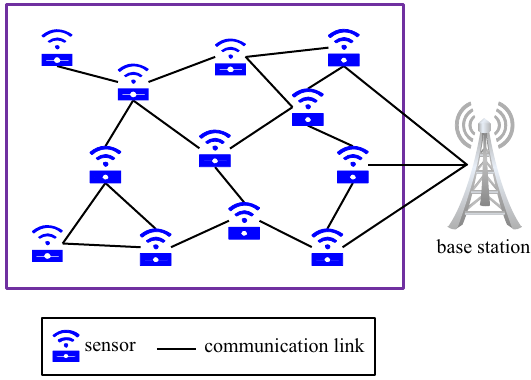
Figure 1. A small-sized WSN.